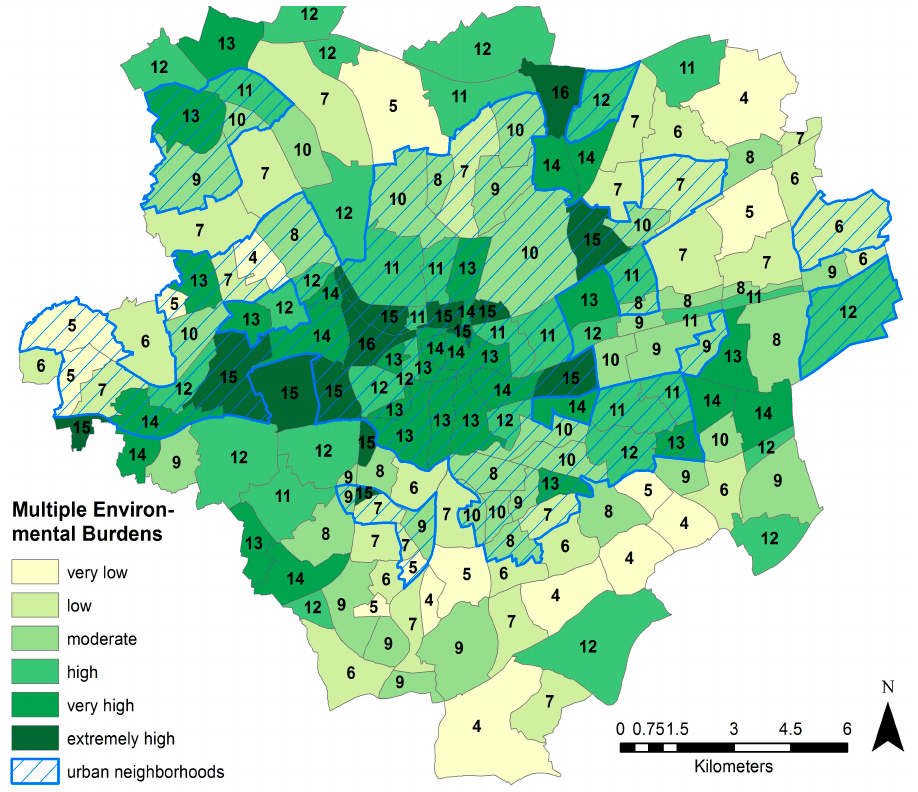
Figure 4. Multiple environmental burdens.